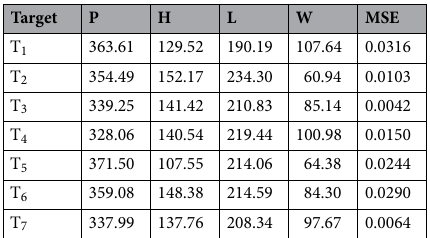
Table 1. Geometric parameters predicted by designed DNN and corresponding mean squared error.